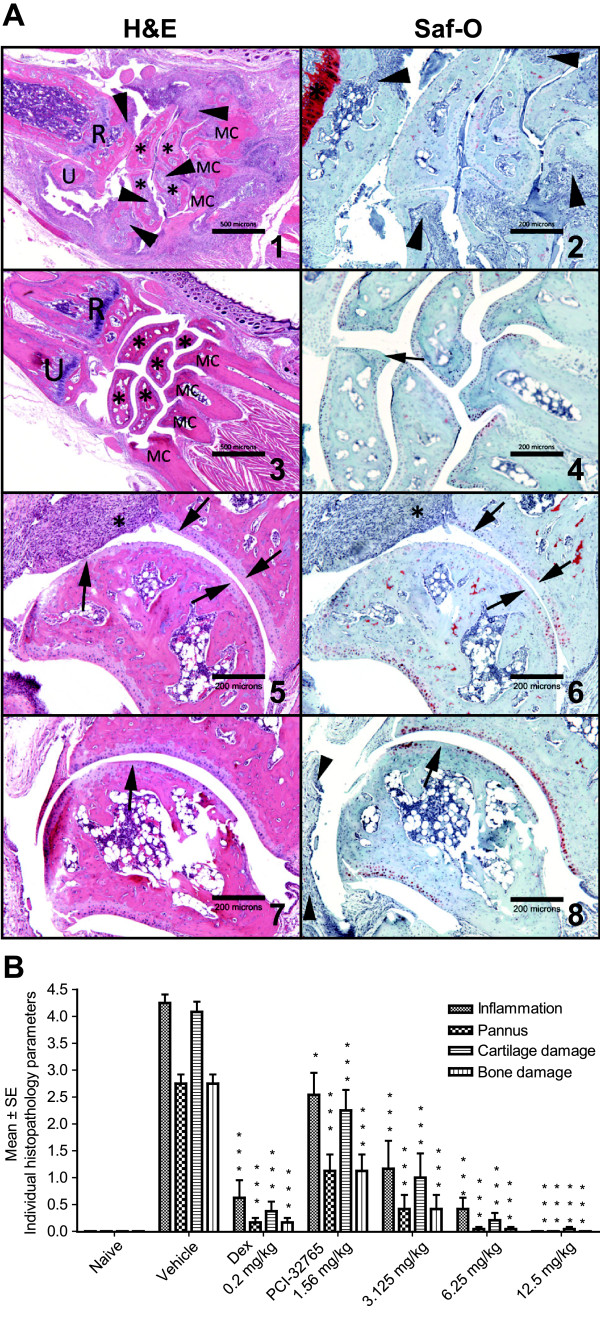
Histopathology images and scores from CIA mice. (a) Histopathology images from collagen-induced arthritis (CIA) mice: 1, 2, 5, and 6 were treated with vehicle; 3, 4, 7, and 8 were treated with 12.5 mg/kg PCI-32765; 1, 2, 3, and 4 were from carpus, 5, 6, 7, and 8 were from tarsus. Images 1, and 3 are magnified 40 ×; 2, 4, 5, 6, 7, and 8 are magnified 100× under the microscope. Bone resorption is depicted with arrowheads; asterisks show carpal bones in panels 1, and 3. R, radius; U, ulna; MC, metacarpal. In panel 5, and 6 asterisks show severe inflammation, and arrows show loss and necrosis of cartilage. In panels 7, and 8 arrowheads show minimum synovial inflammation, and arrow points to minor loss of articular chondrocytes. (b) Histopathology Scores from four joints (carpus and tarsus, both sides) of the CIA mice were averaged and scored by degree of inflammation, pannus, cartilage damage, and bone damage. * P < 0.05, ** P < 0.01; *** P < 0.001 compared with vehicle, analysis of variance.